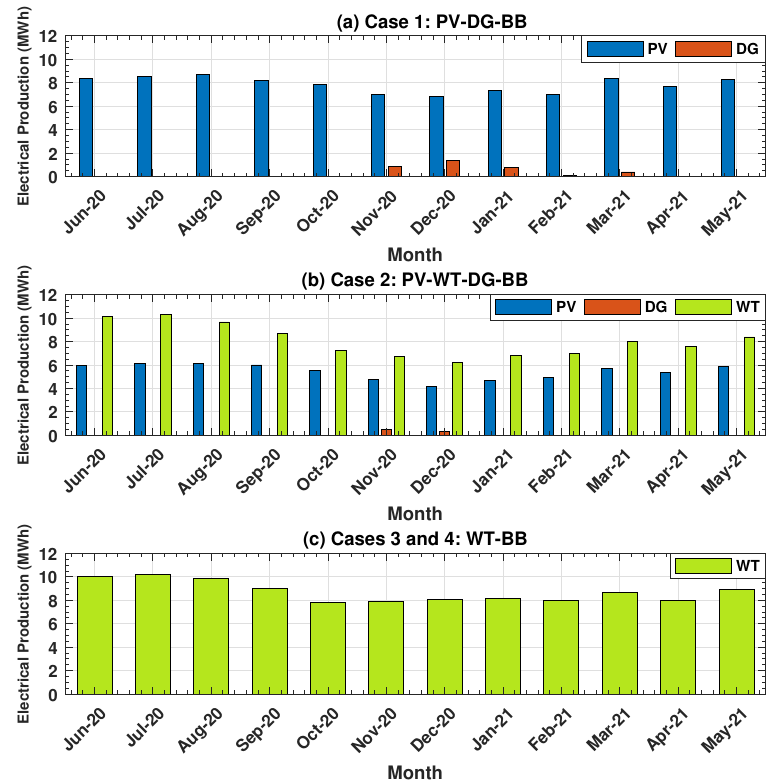
Figure 8. Monthly energy production at Jal-Alayah cell-site for: ( a ) Case 1: PV-DG-BB, ( b ) Case 2: PV-WT-DG-BB, and ( c ) Cases 3 and 4: WT-BB.